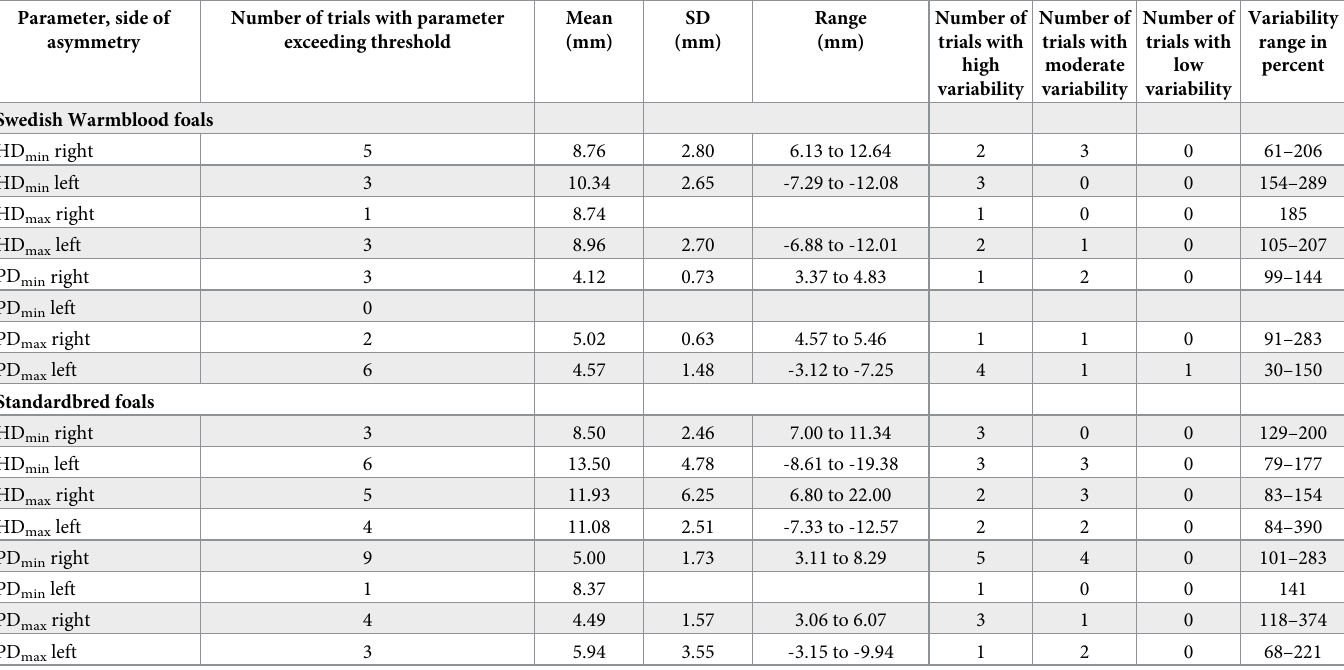
Table 1. Included trials with asymmetry parameters exceeding the threshold values. Parameter, side of Number of trials with parameter asymmetry exceeding threshold